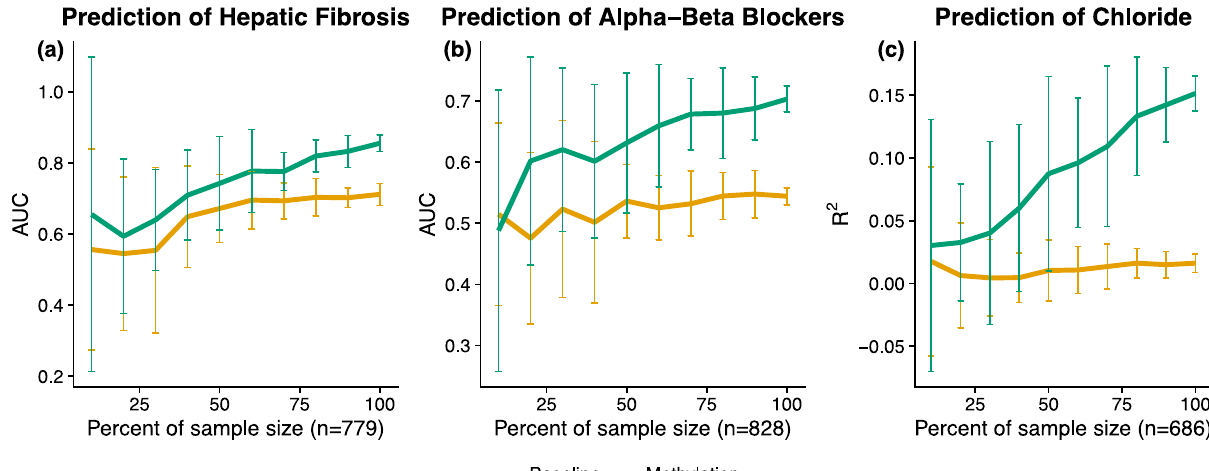
Fig. 3 Imputation accuracy may improve with additional samples. We downsampled the number of individuals to evaluate the imputation performance as a function of sample size using a well-imputed Phecode ( a ), medication ( b ), and lab value ( c ). The performance is signi fi cantly affected by the number of individuals, suggesting that there is additional power to be gained with the addition of more methylation samples. Error bars indicate 95% con fi dence intervals.